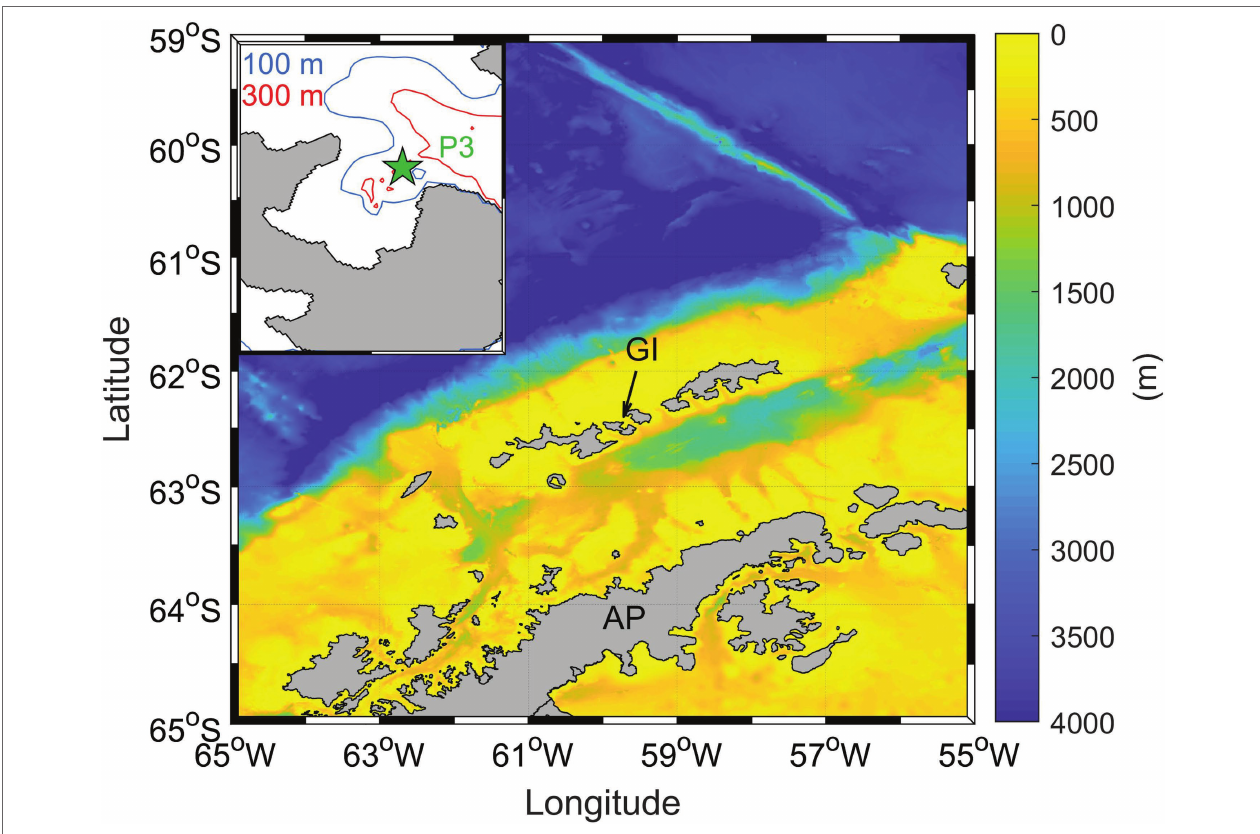
FIGURE 1 | Chile bay location on the Greenwich Island (GI) in the West Antarctic Peninsula (WAP). The green star shows the P3 monitoring station in the